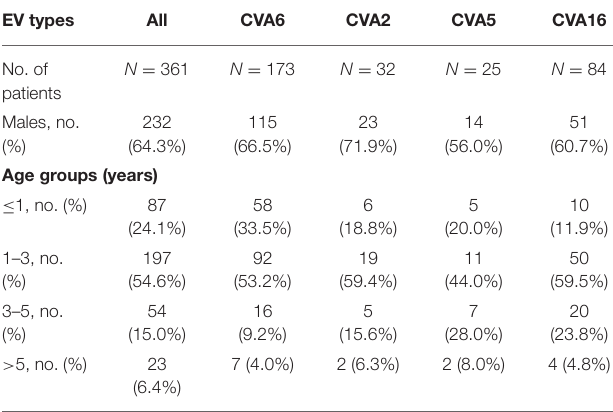
TABLE 2 | Demographics of patients infected with different EVs on admission in this